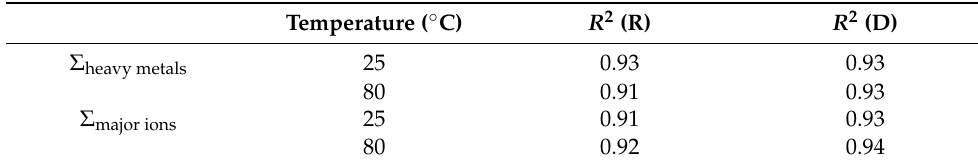
Table 3. Linear correlation coefficient of SCM